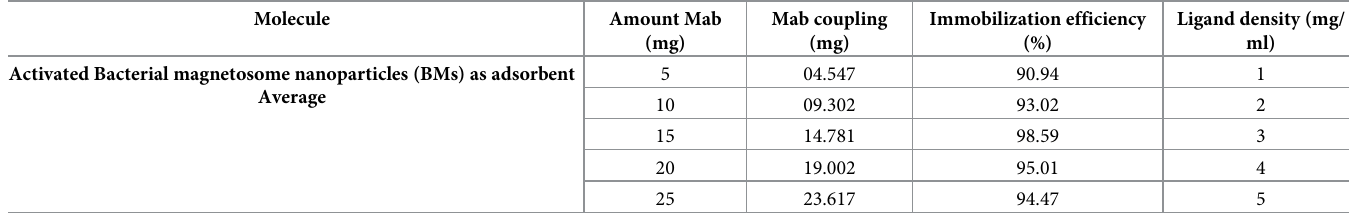
Table 2. Result of antibody immobilization efficiency to BMs nanoparticles as an immunomagnetic adsorbent.